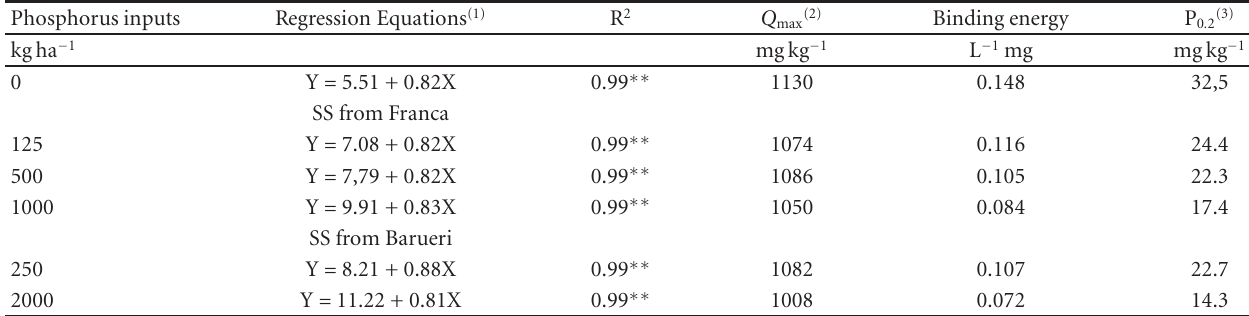
Table 3: Linear Langmuir equations and parameters in the soil samples which received phosphorus addition as biosolids.